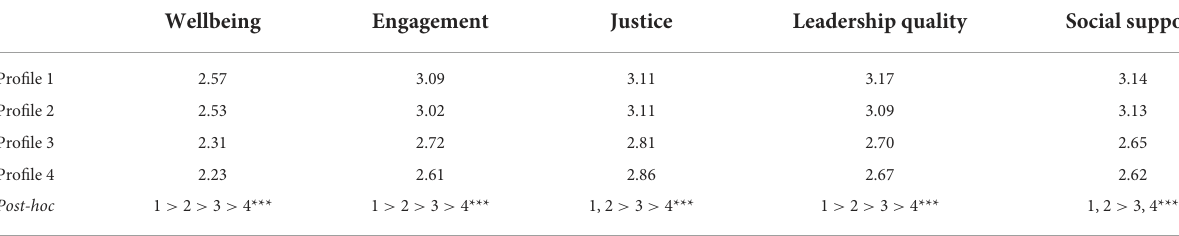
TABLE 5 Means and significant differences with the four-profile model. Wellbeing Engagement Justice Leadership